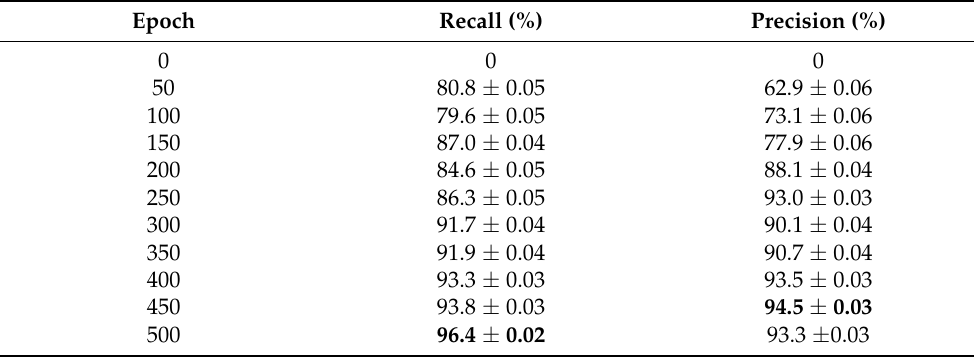
Table 2. The Performance of GBH-YOLOv5, based on 95% confidence interval.